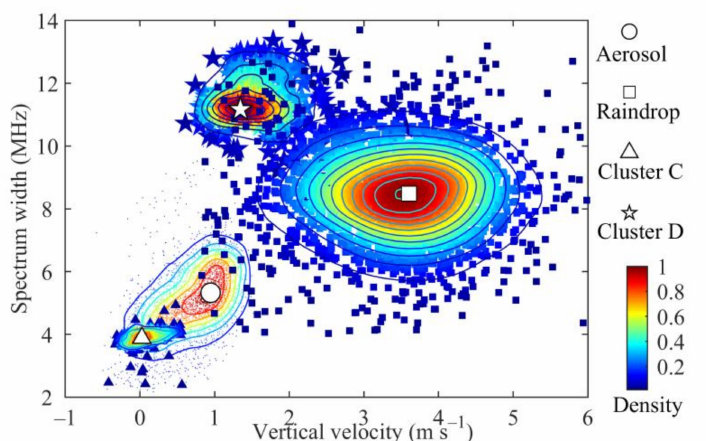
Figure 8. The density distribution of the spectrum width and vertical velocity. The circle, square, triangle, and pentagram represent aerosol, raindrops, and clusters C and